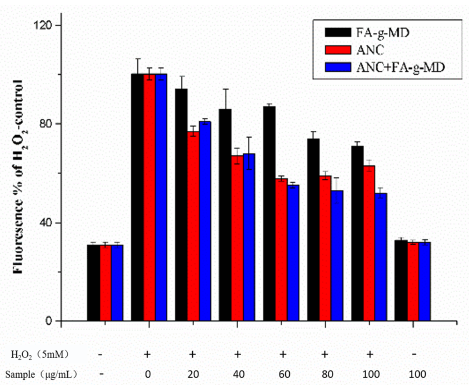
Figure 5. E ff ects of ANC, FA-g-MD and their combination on reactive oxygen species (ROS) generation. The values are expressed as mean SD ( n = ±